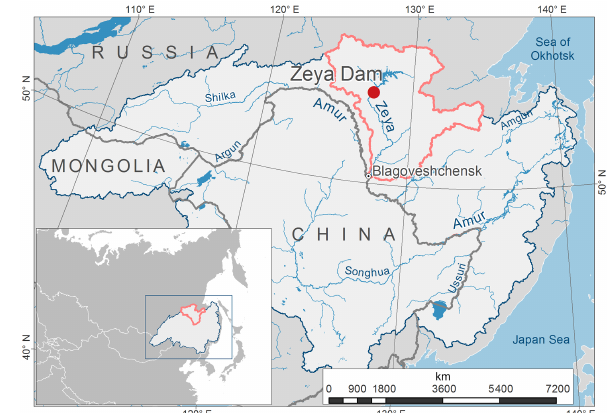
Figure 1. Map of the Amur River basin showing the location of the Zeya River basin and the Zeya dam.